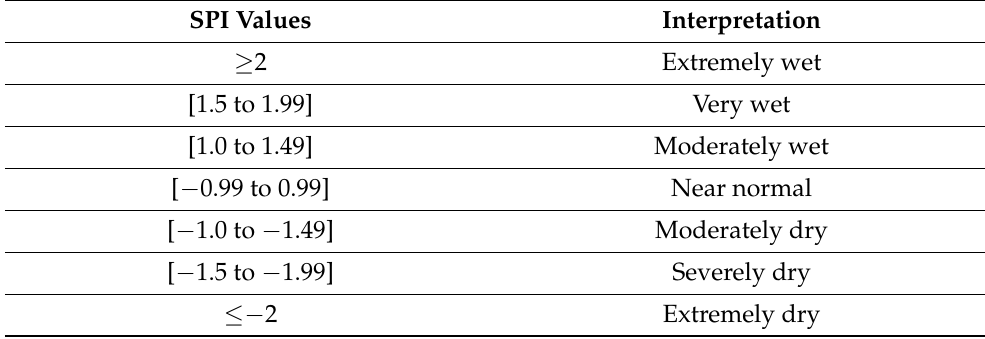
Table 1. Standard Precipitation Index classes and